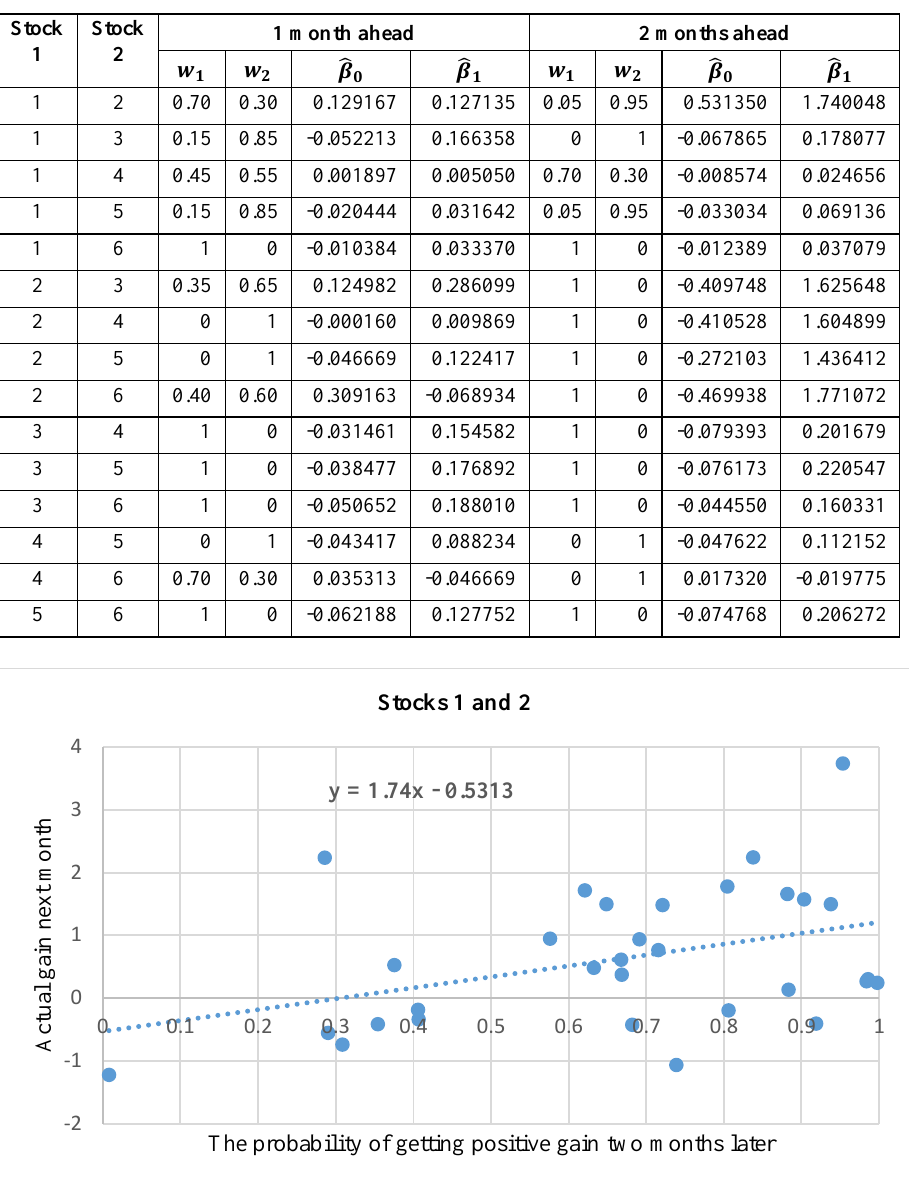
Fig. 1. The results of the regression of actual gain next month on the probability of getting positive gain two months later when stocks 1 and 2 are